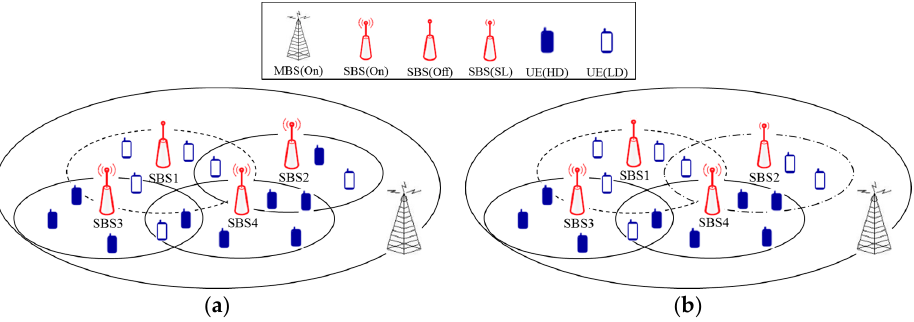
Figure 5. Proposed energy saving operation of BSs in the modified separation architecture ( a ) before energy saving; ( b ) after energy saving.